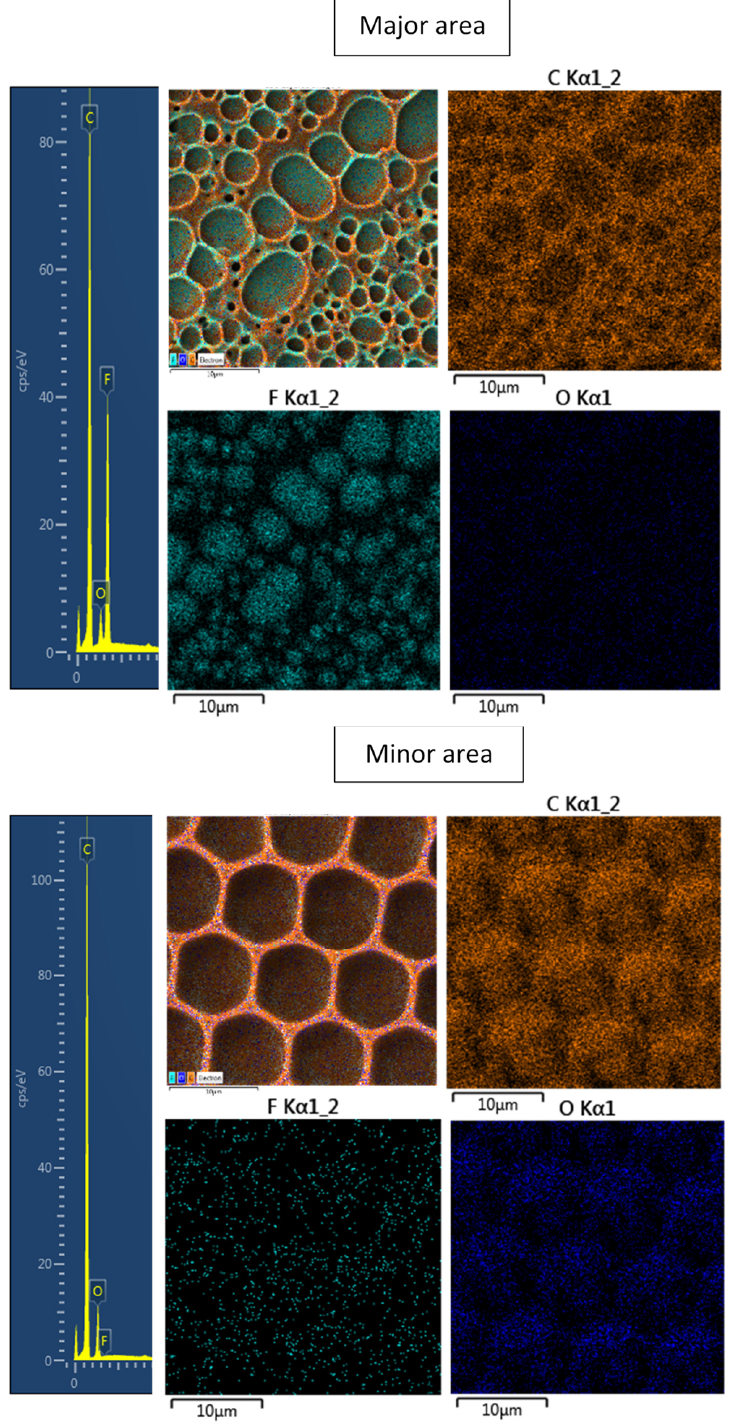
Figure 3. A spectrum from energy-dispersive X-ray spectroscopy (EDS) analysis and elemental maps with layered EDS images for the honeycomb-like pattern major and minor structures on plasma-treated fluorinated ethylene propylene.